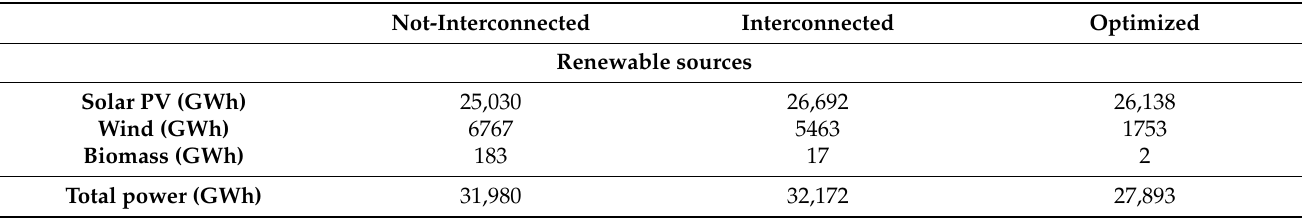
Table 10. Comparison of the electric generation between the three scenarios